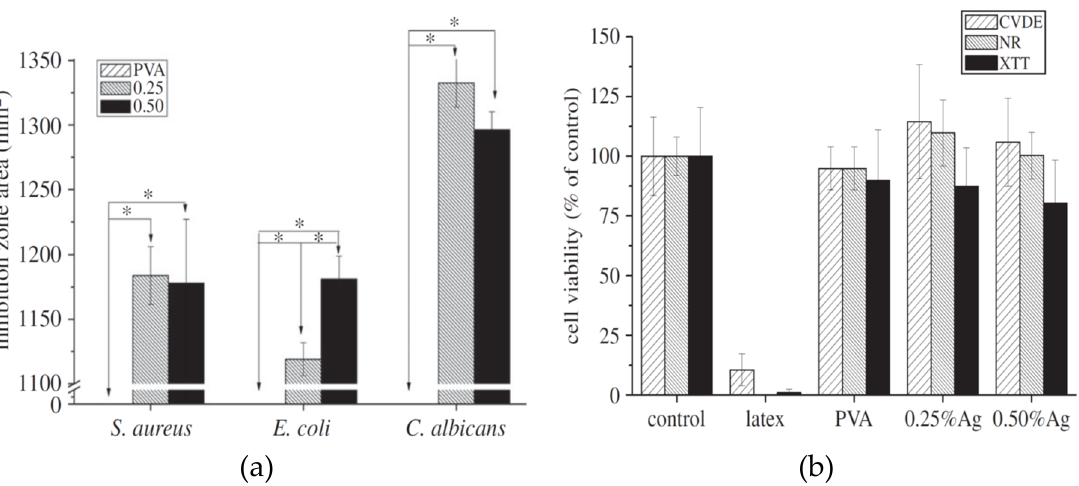
Figure 16. ( a ) Inhibition zones of all samples exposed to S. aureus, E. coli and C. albicans . There is a significant difference between the levels indicated by arrows, * p < 0.05. ( b ) Cell viability of mouse fibroblasts after 24 h incubation with nanocomposite hydrogels. CVDE (cell density), NR (membrane integrity assay) and XTT (mitochondrial activity). ‘Control’ is the negative control, whereas ‘latex’ is the positive control. Reproduced from [184] with permission of the Royal Society Publishing.